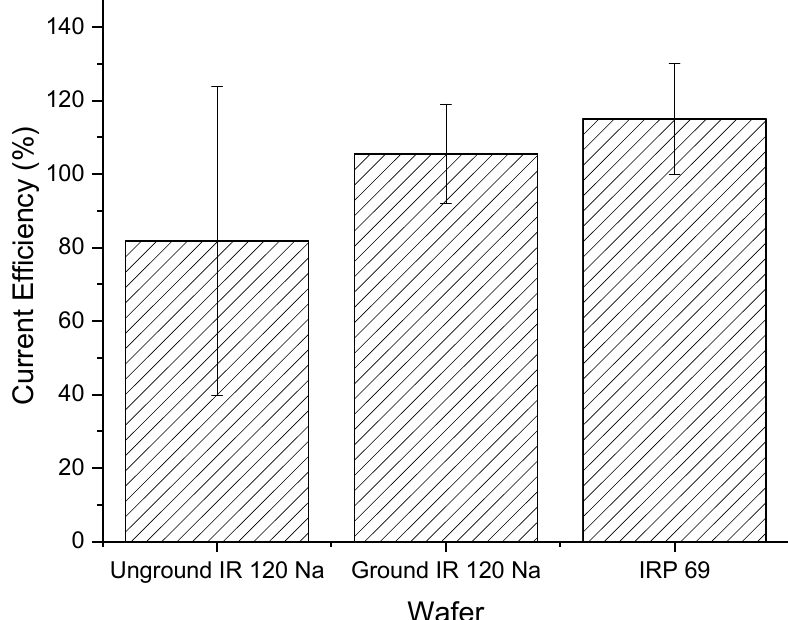
Figure 10 shows the ground IR 120 Na + wafer had a higher and less variable current